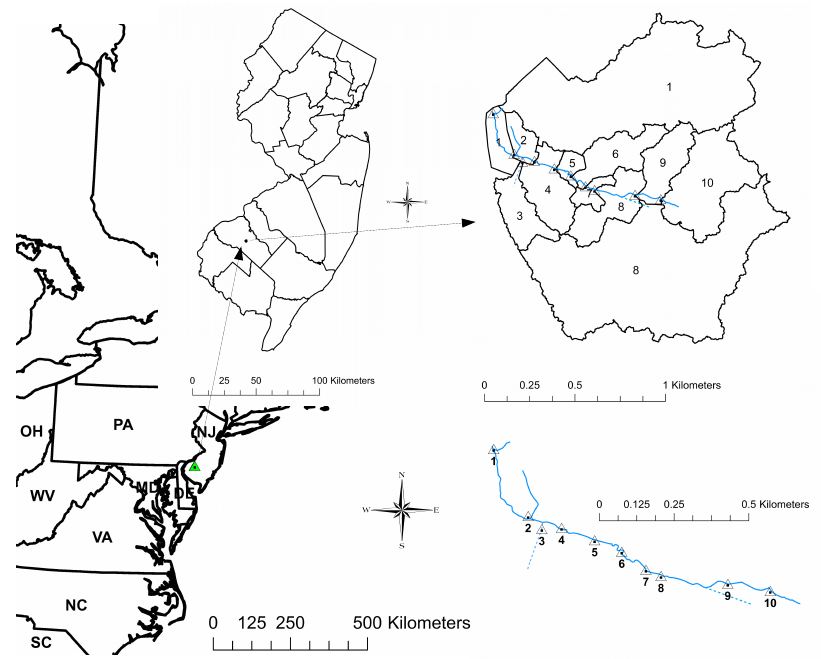
Figure 1. Location of Chestnut Branch. Dashed lines in representation of Chestnut Branch signifies an underground conduit that drains into the stream.